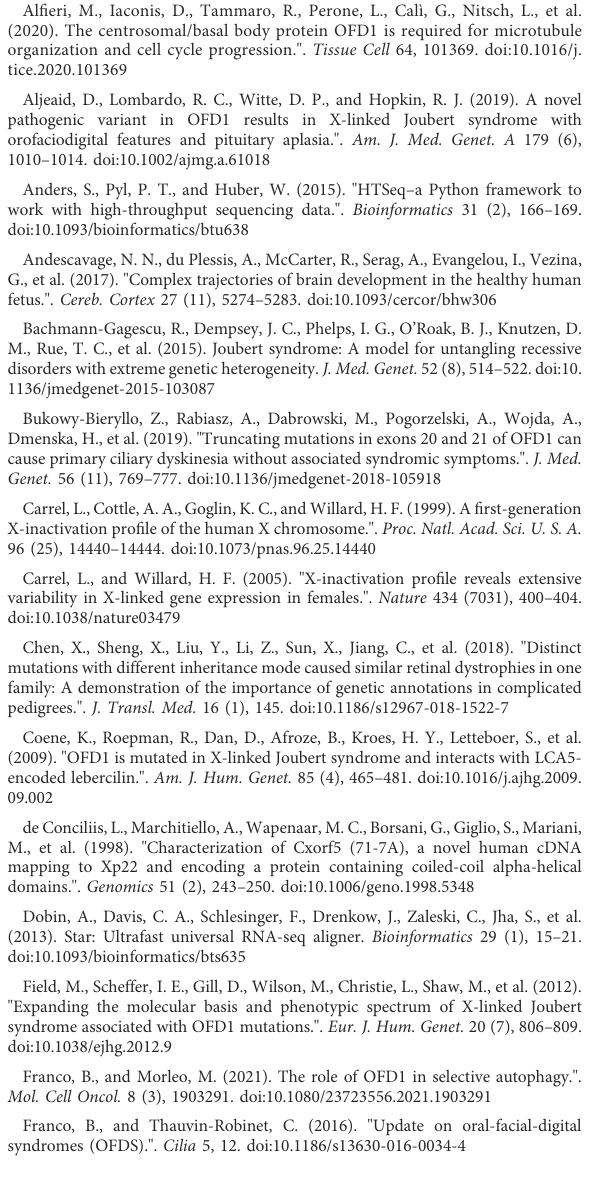
SUPPLEMENTARY FIGURE S1 Assessment of the pathogenicity of variation OFD1 (NM_003611.3): c.2848A > T (p.Lys950Ter) by VarSome (https://varsome.com/). SUPPLEMENTARY FIGURE S2 The predicted structure of the mutant protein and wild-type protein by RoseTTAFold online software. (A) (wild-type protein), (B) (mutant protein). SUPPLEMENTARY FIGURE S3 The CMA analysis of the fetus (II-3), which shows a 696 kb heterozygous deletion at 5p13.33